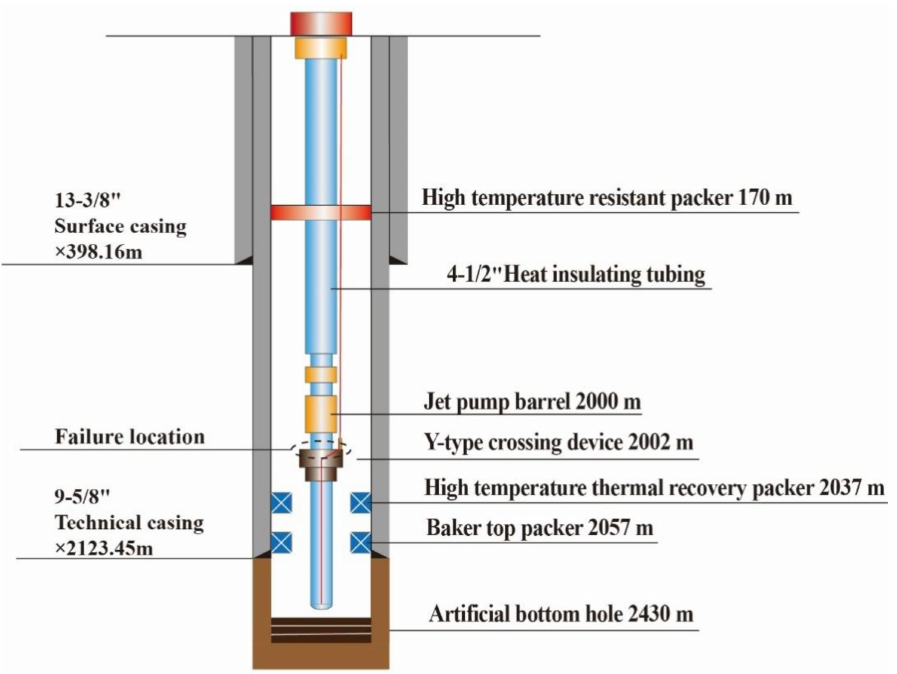
Figure 1. Schematic diagram of integrated injection-production string.